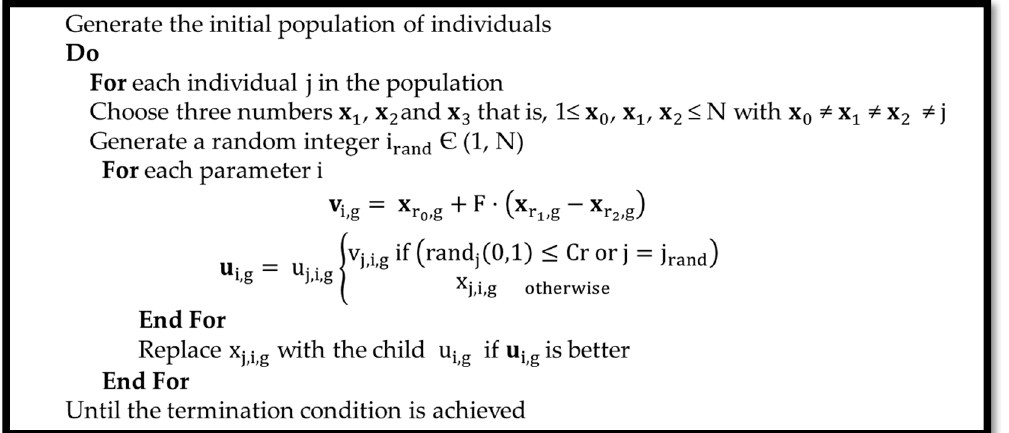
Figure 12. Differential evolution algorithm.